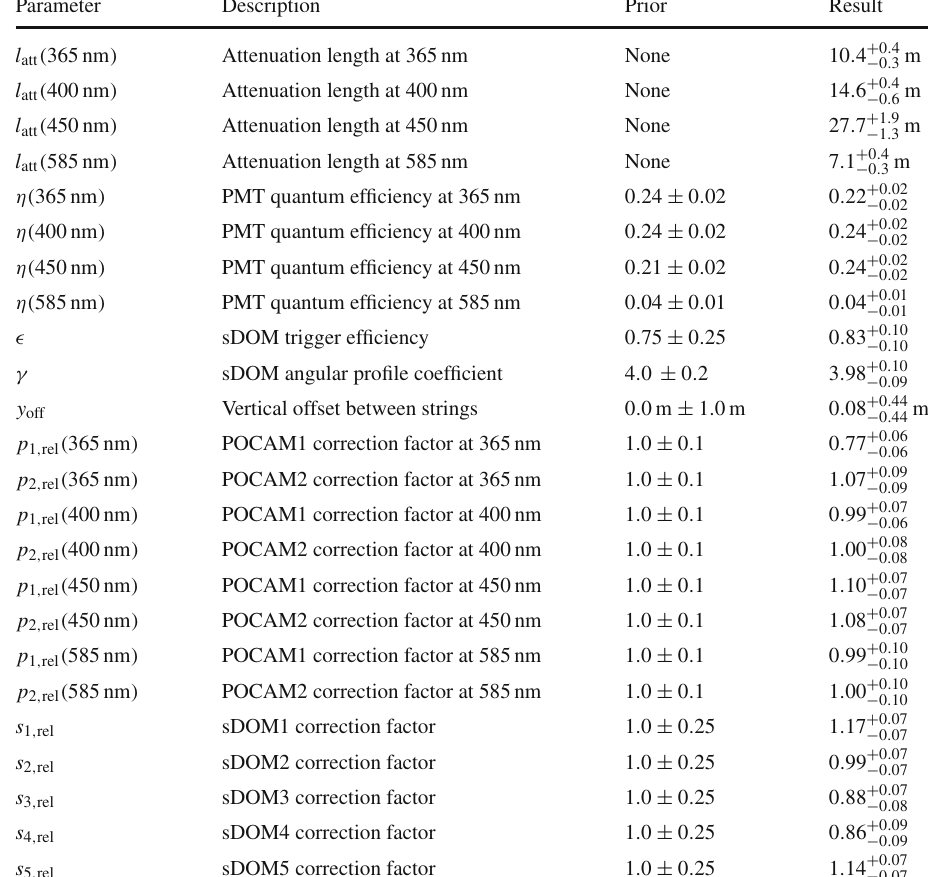
Table 1 Parameters for the attenuation length fit and results of the Markov Chain Monte Carlo sampling. Priors are given with Gaussian sigma. Results extracted from posterior distributions correspond to the 50th, 16th and 84th percentile, respectively